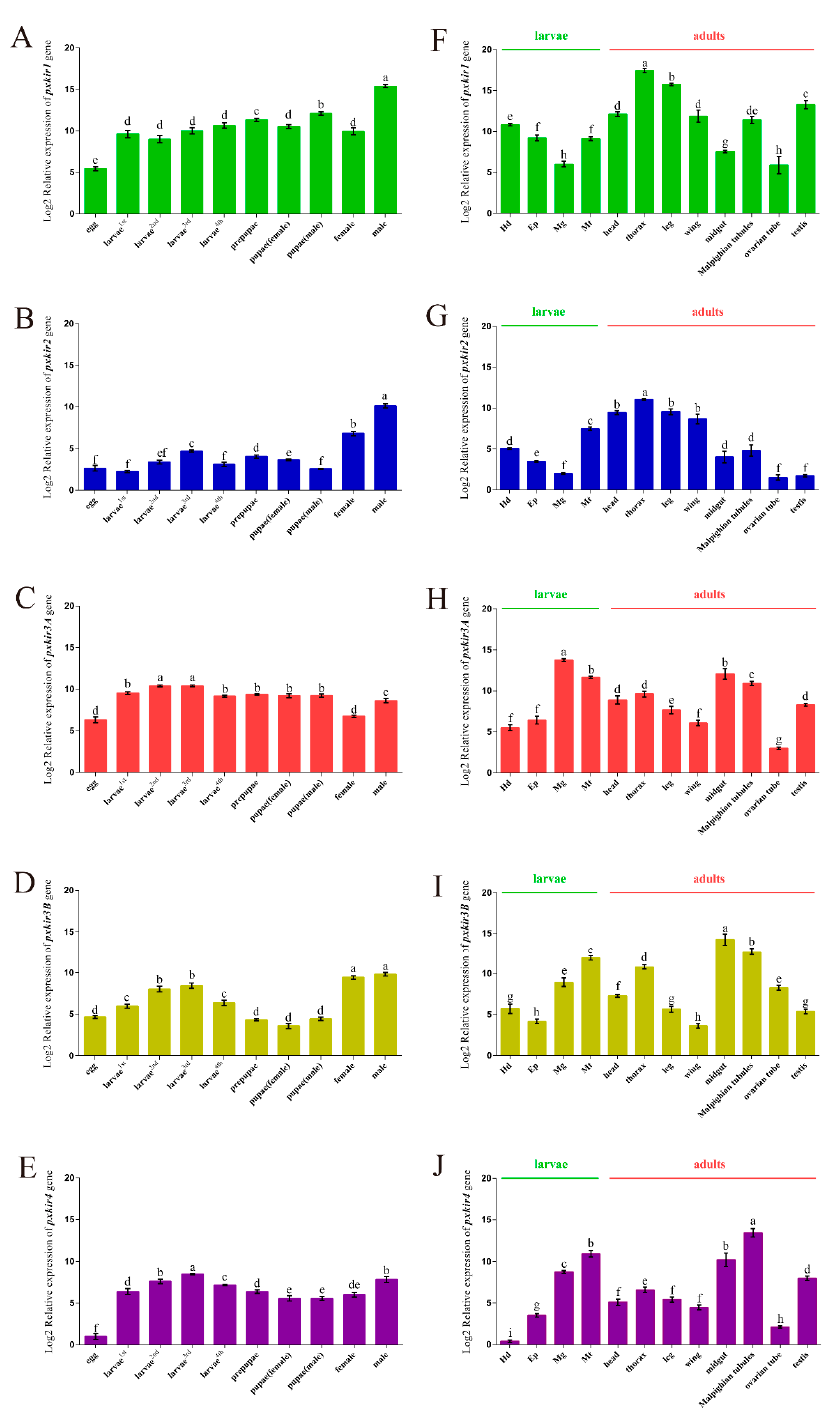
Figure 4. Log2 relative mRNA expression levels of pxkirs at di ff erent developmental stages ( A – E ) and in di ff erent tissues ( F – J ). Di ff erent developmental stages of P. xylostella , including eggs, 1st to 4th instar larvae, prepupae, pupae (female and male), and adults (female and male). The expression level of pxkir4 during the egg period was defined as a benchmark for statistical analysis, using rpS4 as the reference gene. Di ff erent tissues come from larvae (fourth instar) and adults. Tissue abbreviations: head (Hd), epidermal samples (Ep), Malpighian tubules (Mt), and midgut (Mg). The expression level of the pxkir4 during the egg period was defined as a benchmark for statistical analysis, by using rpL8 as a reference gene. Di ff erent lower-case letters above the bars indicate significant di ff erences. The data are presented as means ± SD (N >